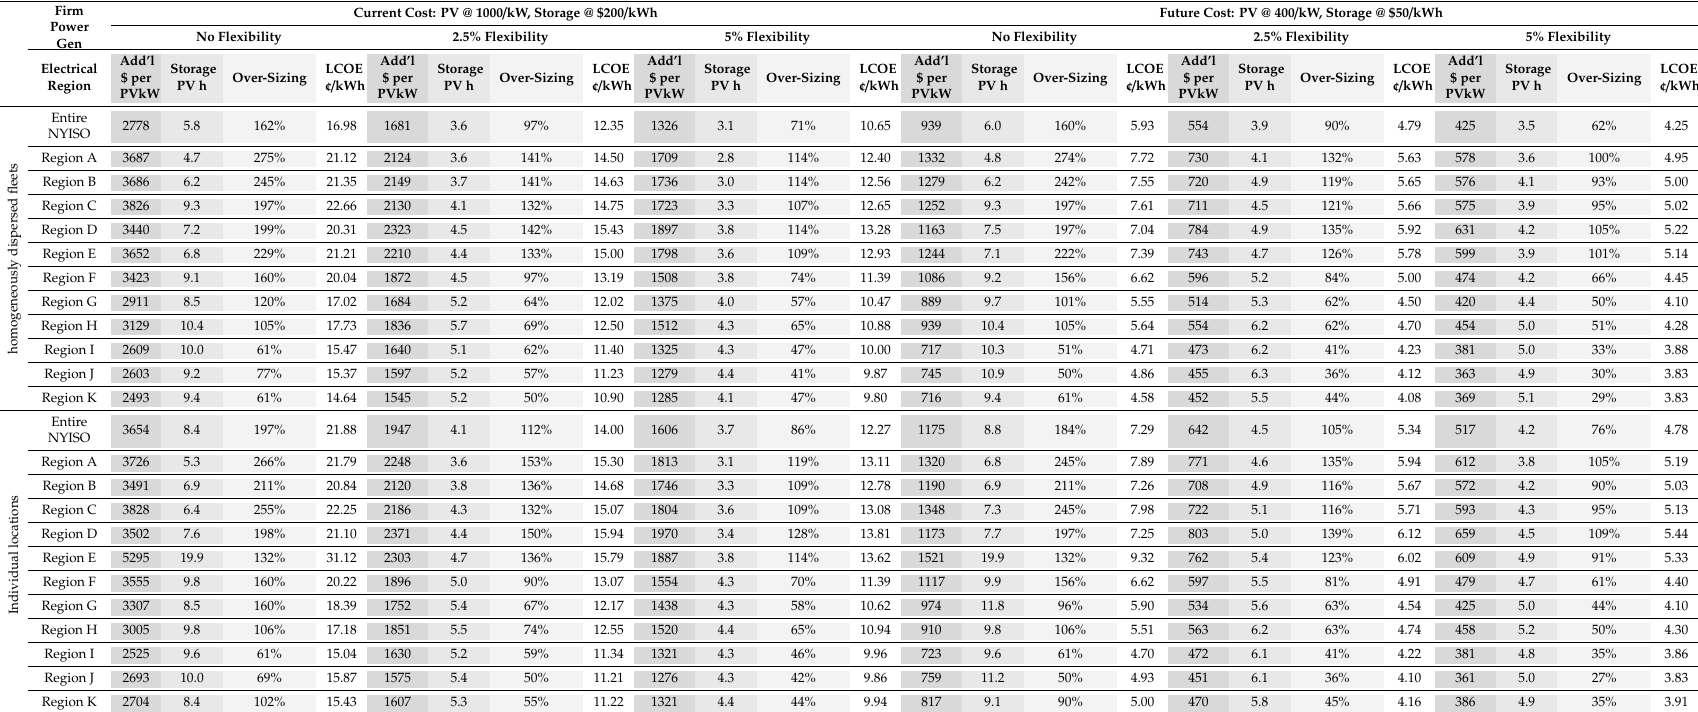
Table 8. Firm generation at 50%